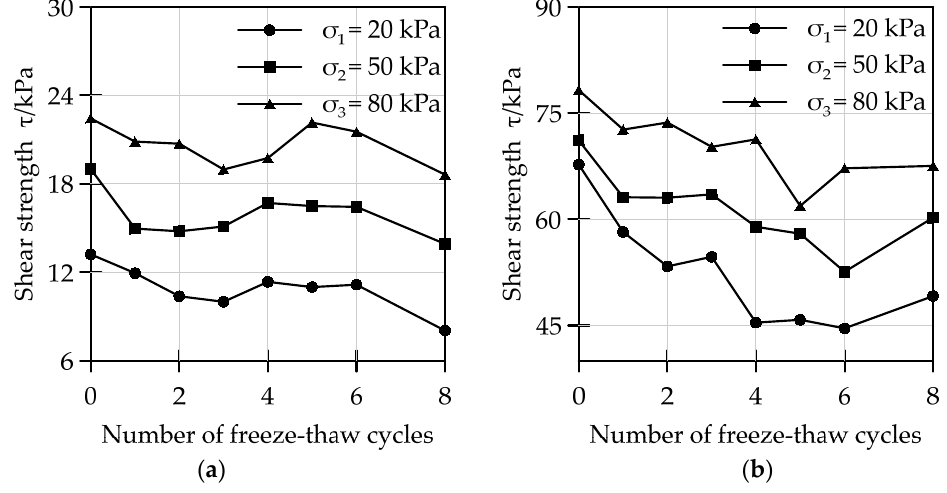
Figure 3. The relationship curve of F-T cycles and shear strength: (a) S0 and (b) S2.